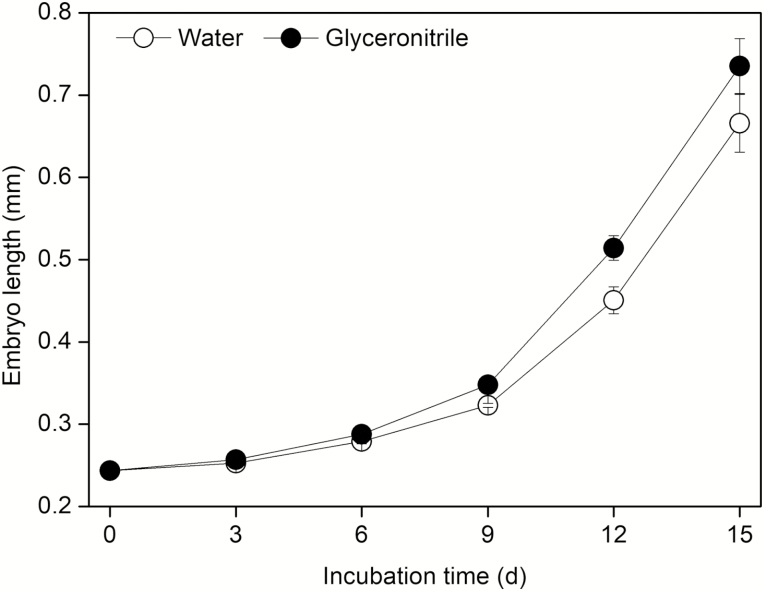
Embryo growth (mean ± SE) dynamics of after-ripened Anigozanthos flavidus seeds incubated at 15 °C in Petri dishes containing 0.7 % (w/v) on water agar (control, white circle) or water agar containing 50 μM glyceronitrile (black circle). The embryo length was determined after 0, 3, 6, 9, 12 and 15 days of incubation. Four dishes of 100 seeds were used for each sampling time point.